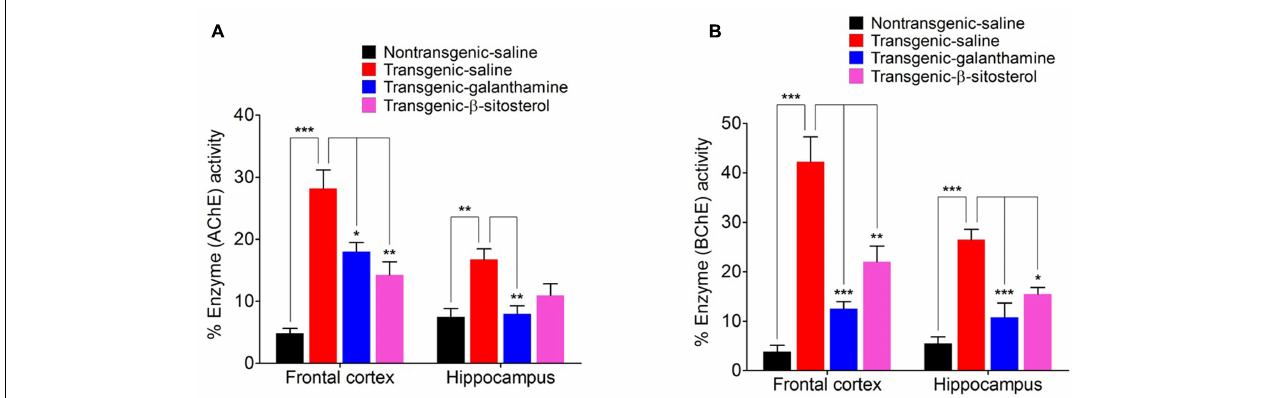
FIGURE 6 | Effect of β -sitosterol on the activities of AChE (A) and BChE (B) in the frontal cortex and hippocampus of different groups animals. Bars represent mean percent AChE or BChE activity ± SEM. ∗ P < 0.05, ∗∗ P < 0.01, ∗∗∗ P < 0.001, one-way ANOVA followed by post hoc Tukey’s test.